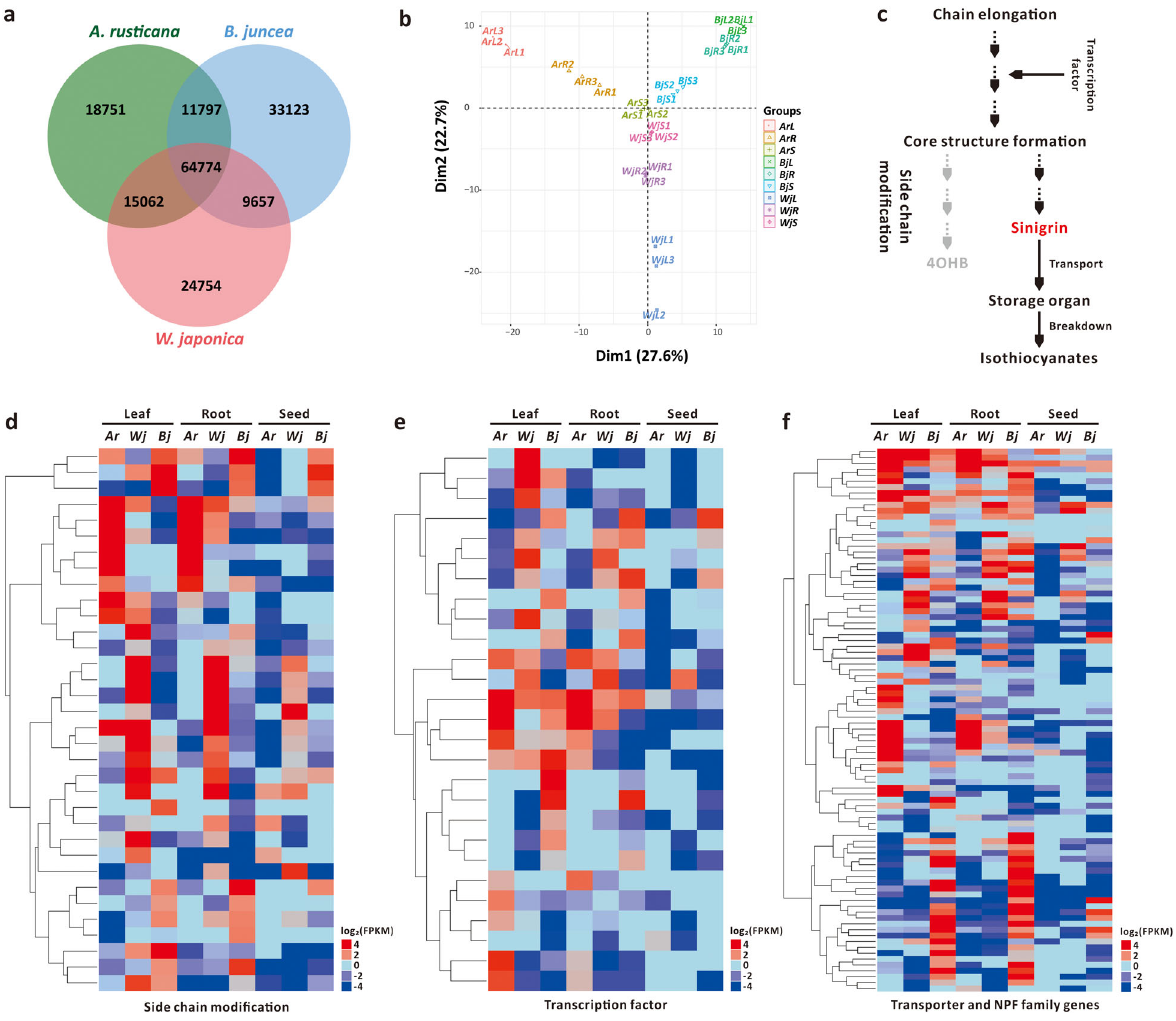
Fig. 2 De novo transcriptome assemblies and transcriptional expression levels of genes related to GSL metabolism in W . japonica , A . rusticana , and B . juncea . a Venn diagram of the transcriptomes of W . japonica , A . rusticana , and B . juncea . b Principal component analysis of the transcriptomes from the leaves, roots and seeds of W . japonica , A . rusticana , and B . juncea . c Schematic pathway of the biosynthesis, transport and breakdown of sinigrin. d Expression levels of genes related to the side chain modi fi cations of GSL biosynthesis. e Expression levels of genes involved in the transcriptional regulation of GSL biosynthesis. f Expression levels of genes related to the transport of GSLs and in the NPF